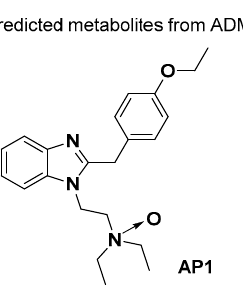
Figure 1. Possible metabolites of etazene were found in the human liver microsomal assay and rat serum and urine [18] and predicted by the ADMET predictor v10.0.0.11 (Simulation Plus, Lancaster, CA, USA).